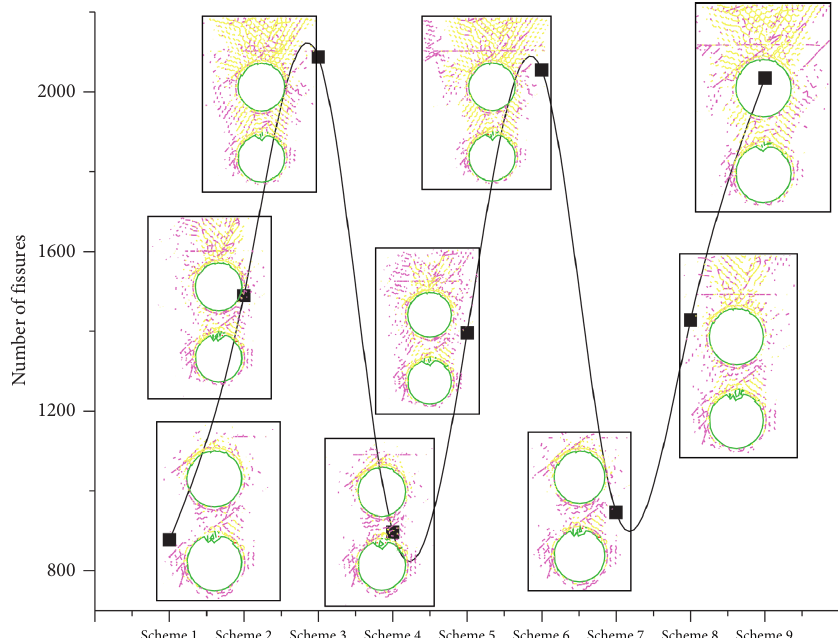
Figure 8: Number and distribution of